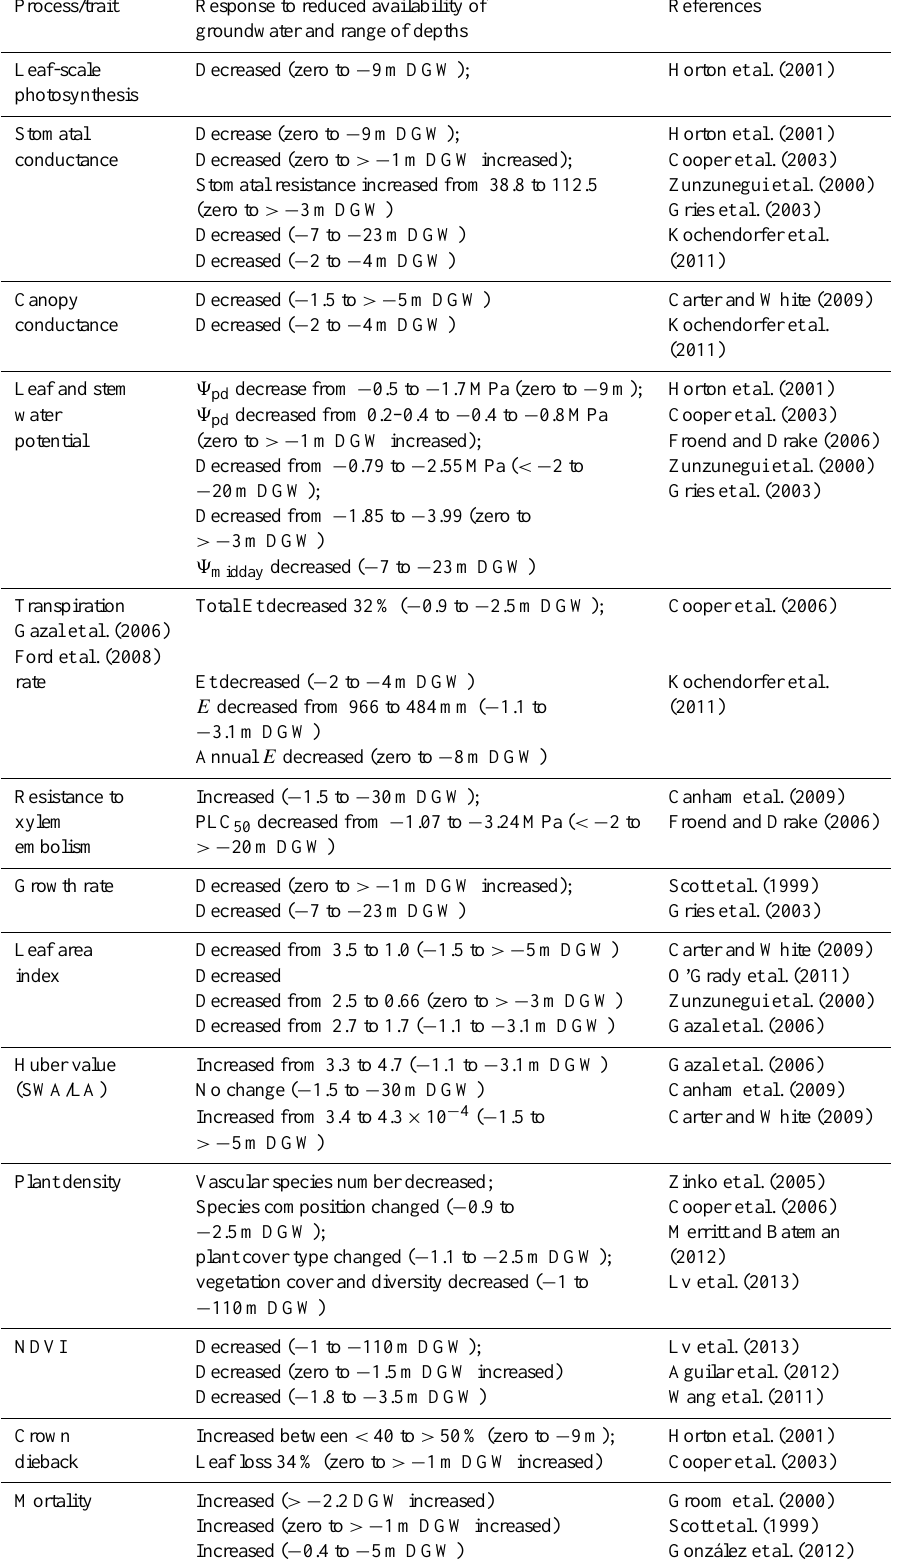
Table 3. A summary of some of the recent literature documenting the response of vegetation, across multiple scales, to reduced availability of